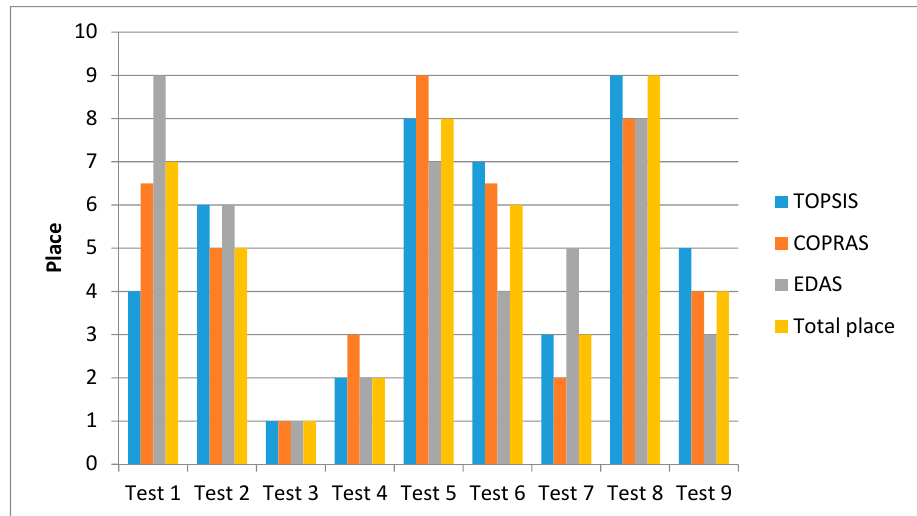
Figure 7. Results of multi-criteria decision-making (MCDM) methods evaluation for The Technique for Order of Preference by Similarity to Ideal Solution (TOPSIS), Complex Proportional Assessment (COPRAS) and Evaluation Based on Distance from Average Solution (EDAS) methods for a 60 Hz vibration frequency.